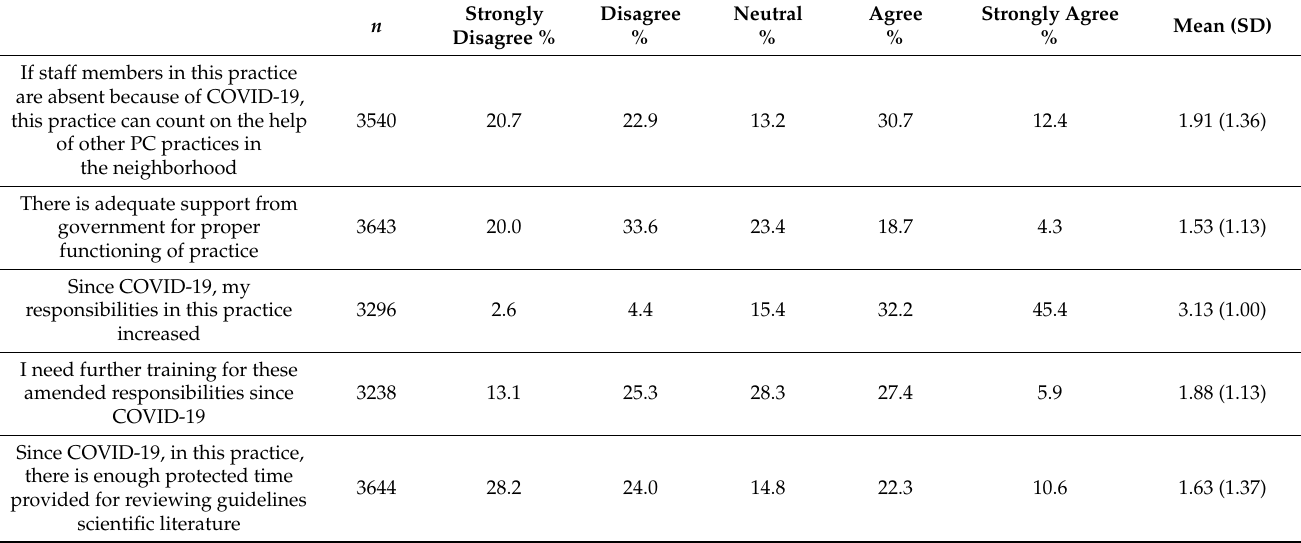
Table 2. Respondents’ opinions of the effects of the COVID-19 pandemic on their practice.